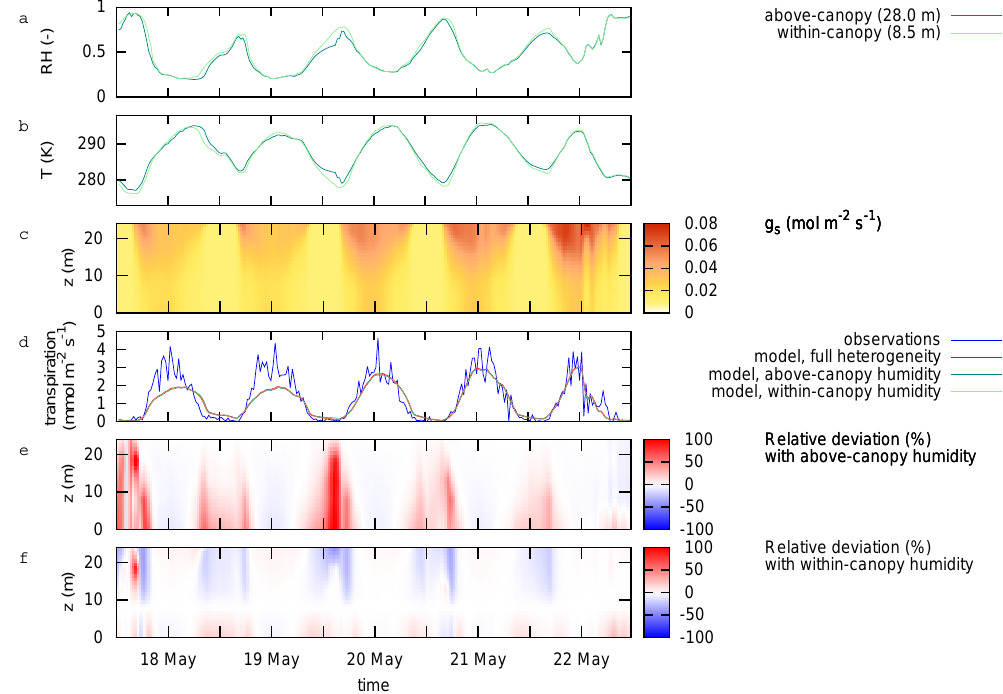
Figure 5. Effect of temperature and humidity conditions on transpiration for the case period 18 to 22 May 1999: (a) above-canopy (28.0m) and within-canopy (8.5m) relative humidity; (b) above-canopy and within-canopy temperature; (c) simulated profile of stomatal conductance, averaged per layer; (d) simulated transpiration, as well as observed H 2 O flux; (e) relative deviation in simulated transpiration when apply- ing above-canopy humidity (simulation HOM_HUM_AC); (f) relative deviation in simulated transpiration when applying within-canopy humidity (simulation